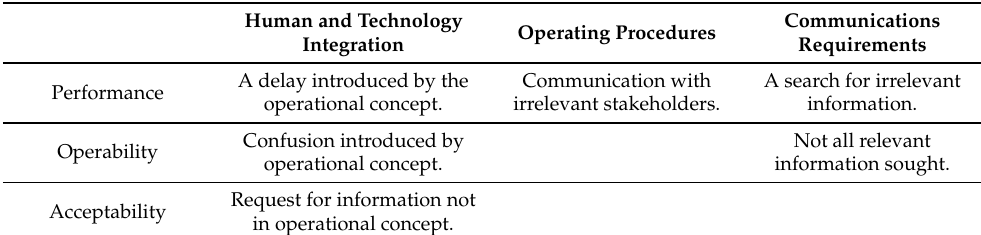
Table 1. E-OCVM operational aspect evaluation to guide interview